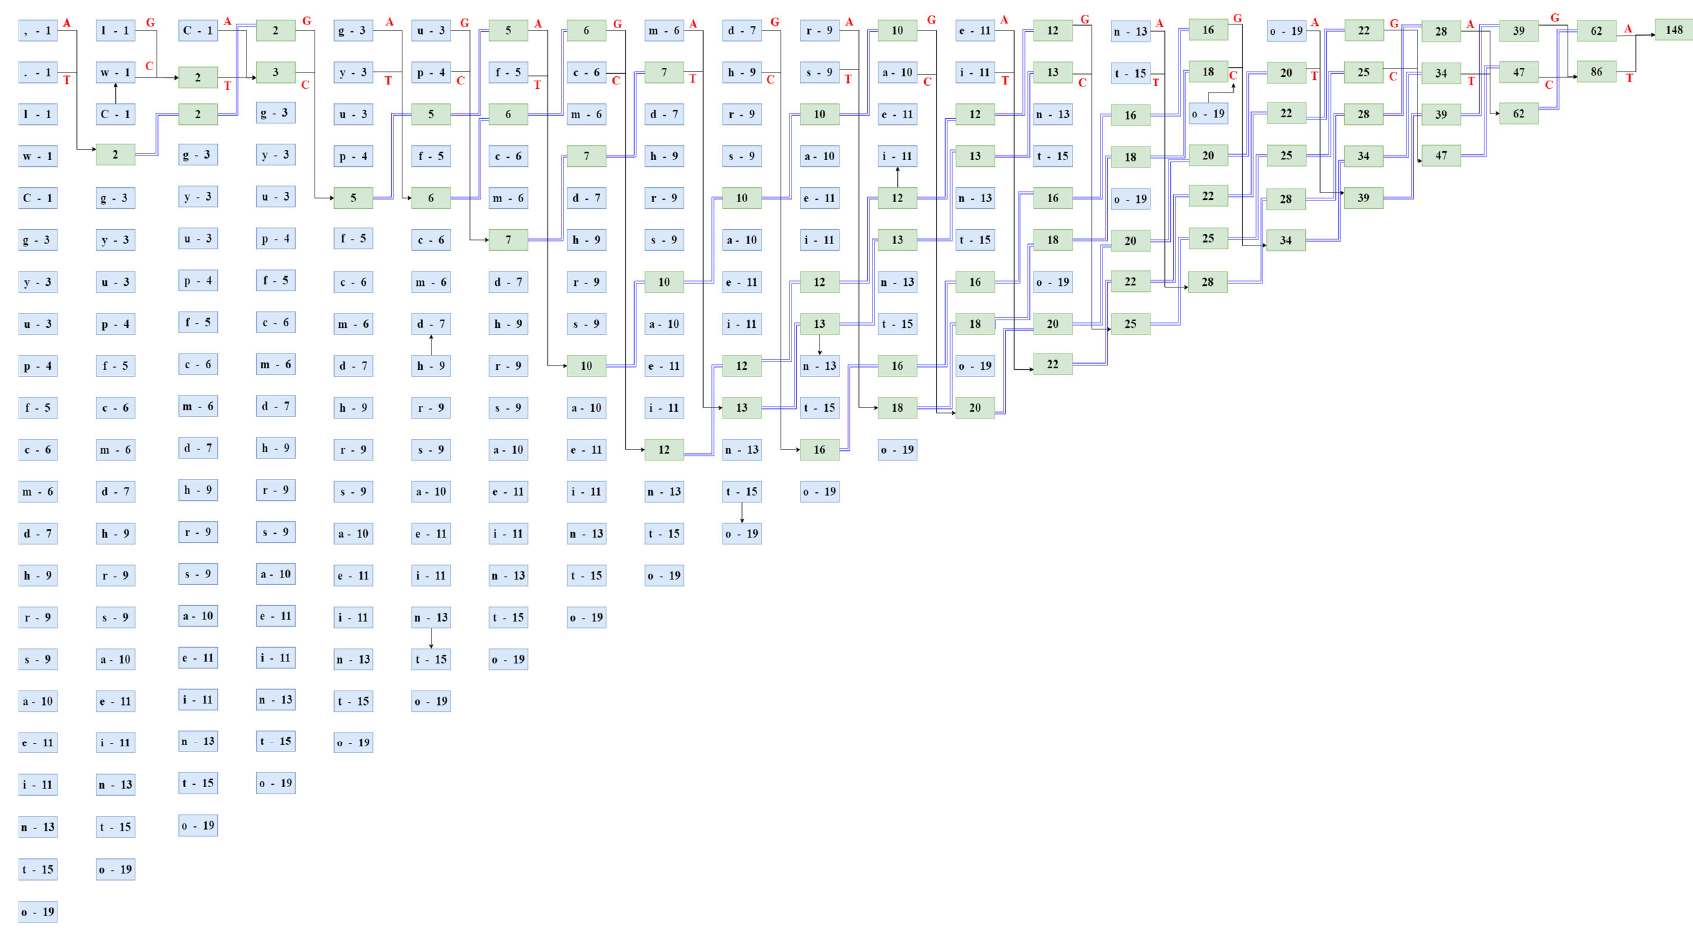
Figure 10. Demonstration of Huffman Tree Generation.